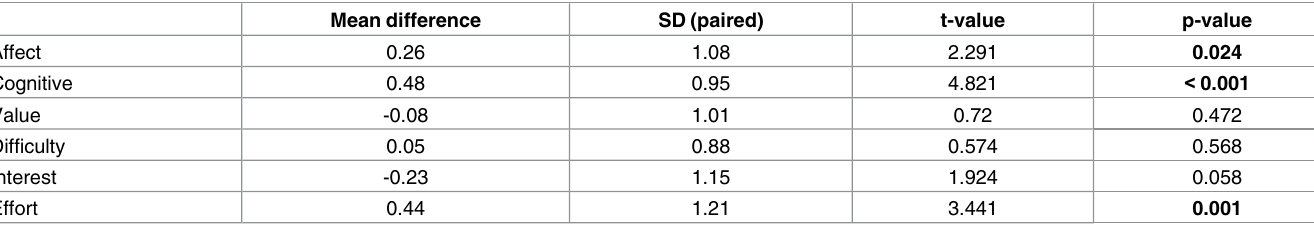
Table 3. Changes in student attitudes towards statistics after course completion (n =